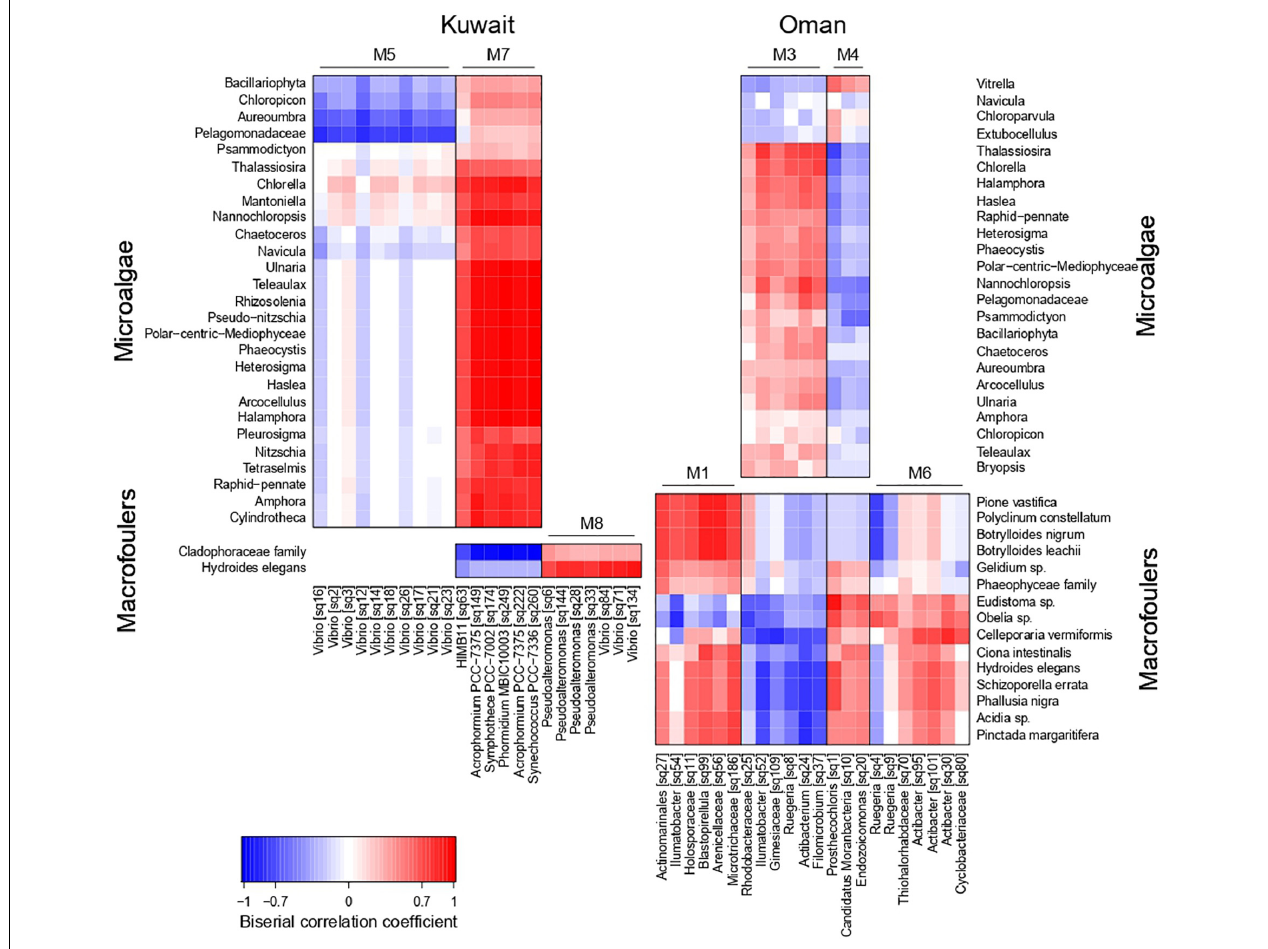
FIGURE 5 | Heatmap showing association patterns between bacterial co-occurrence network modules (represented by their characteristic OTUs) and microalgae (upper heatmaps) and macrofoulers (lower heatmaps) in Kuwait (left hand side) and Oman (right hand side) .